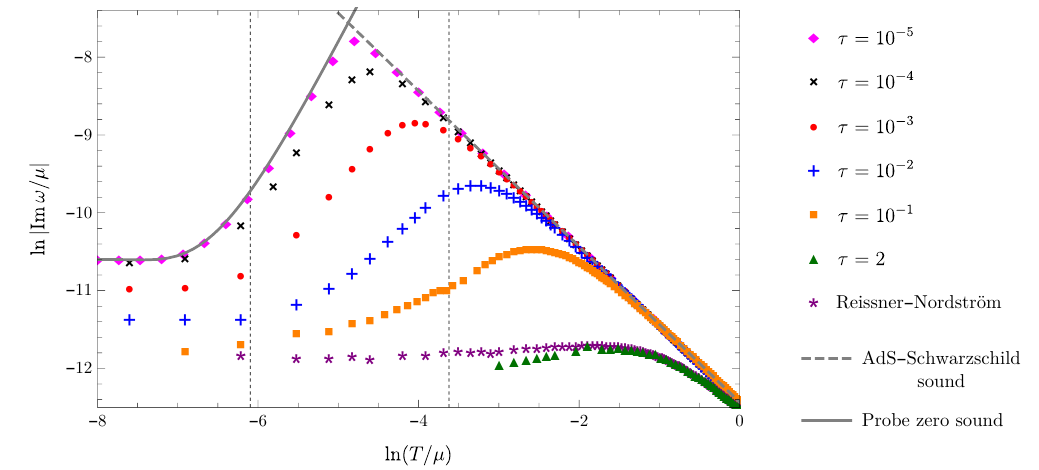
Figure 18. Our numerical results for ln j Im ( !=(cid:22) ) j versus ln ( T=(cid:22) ) for ~ (cid:11) = 1, k=(cid:22) = 10 (cid:0) 2 , and (cid:28) = 10 (cid:0) 5 (pink diamonds), 10 (cid:0) 4 (black crosses), 10 (cid:0) 3 (red dots), 10 (cid:0) 2 (blue plus signs), 10 (cid:0) 1 (orange squares), and 2 (green triangles), as well as the AdS-RN result (purple stars). The solid gray line is the numerical result in the probe limit, while the dashed gray line comes from Im ( ! ) = (cid:0) (cid:0) k 2 with the d = 3 AdS-SCH value (cid:0) = 1 = (8 (cid:25)T ) (dashed gray). The vertical dashed black lines indicate the LFL de(cid:12)nitions of the boundaries between quantum and thermal collisionless regimes, ln ( T=(cid:22) ) (cid:25) (cid:0) 6 : 09, and between thermal collisionless and hydrodynamic regimes, ln ( T=(cid:22) ) (cid:25) (cid:0) 3 : 62. For ln ( T=(cid:22) ) . (cid:0) 6 : 09, all cases exhibit j Im ( ! ) j / T 0 , similar to the LFL quantum collisionless regime. For ln ( T=(cid:22) ) & (cid:0) 6 : 09, j Im ( ! ) j exhibits scaling with a power of T that decreases as (cid:28) increases, from T 2 down to, but not exactly to, T 0 . As ln ( T=(cid:22) ) increases, in all cases such scaling eventually ends in a maximum, followed by j Im ( ! ) j / T (cid:0) 1 , as expected for a CFT in the hydrodynamic regime. As (cid:28) increases the maximum’s position moves beyond the LFL value, ln ( T=(cid:22) ) (cid:25) (cid:0) 3 : 62, and its height decreases. Nevertheless, all cases have a maximum, so the LFL de(cid:12)nition of the crossover is viable.